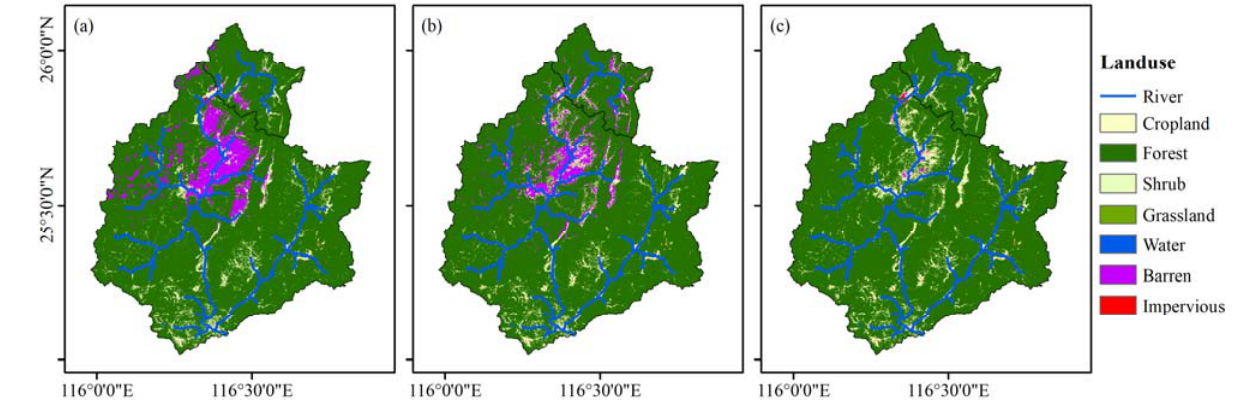
Figure 10. Land ‐ use maps of 1985 ( a ), 1995 ( b ), and 2005 ( c ). Figure 10. Land-use maps of 1985 ( a ), 1995 ( b ), and 2005 ( c ).